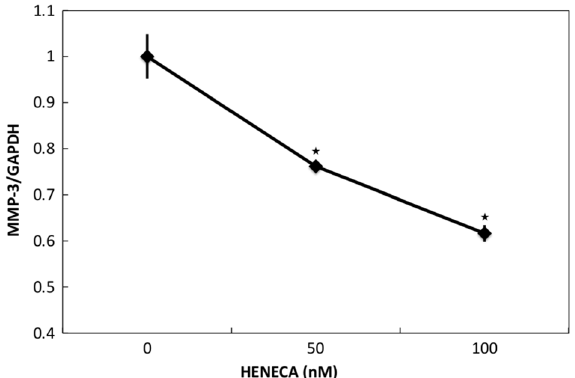
Figure 3. Stimulation of A 2A AdoRs reduced the basal and TNFα-induced MMP-3 expression by MH7A cells. Activation of A 2A receptors suppressed constitutive expression of MMP-3 mRNA in MH7A cells. Cells were incubated for 24 h with the indicated concentration of HENECA, and MMP-3 mRNA levels estimated by RT-PCR. Experiments were repeated three times, and data are presented as the mean ± SD. ★ p < 0.05 and ★★ p < 0.01 vs. 0 μM